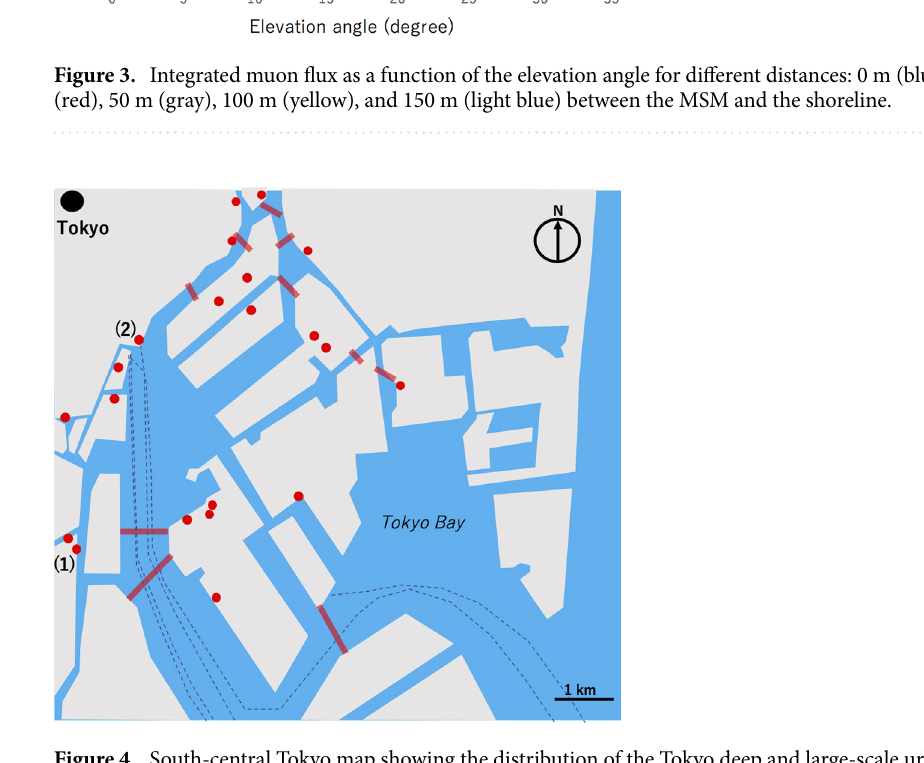
Figure 4. South-central Tokyo map showing the distribution of the Tokyo deep and large-scale urban underground spaces (UUSs) located in the regions within 200 m from the shorelines. Commercial UUSs including subway stations, shopping areas and parking lots (filled red circles) and underwater tunnels (red bold lines) are shown. Dashed lines indicate the ocean lines. The points (1) and (2) indicate the locations of the